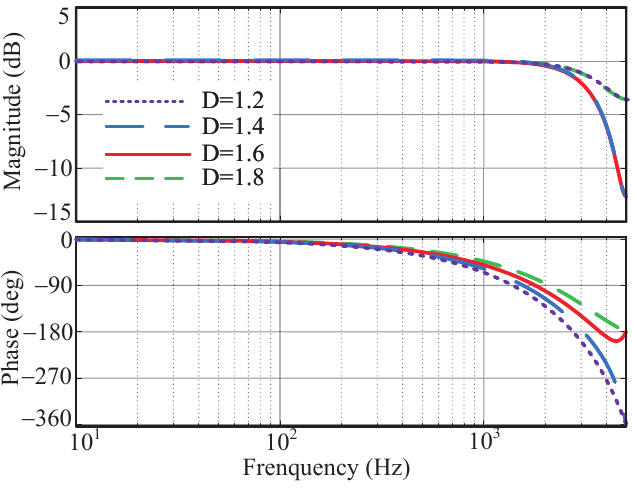
Figure 8. Frequency responses of Lagrange-interpolation-based FD